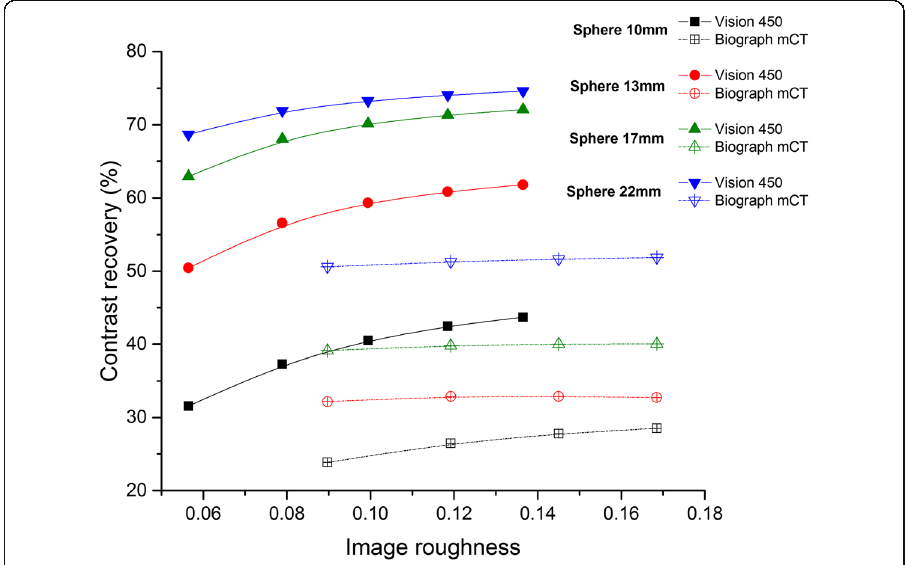
Fig. 3 3D contrast recovery computed for Vision (solid line) and mCT (dotted line). Each point is for a specific number of iterations. Datasets from the two scanners have the same number of net